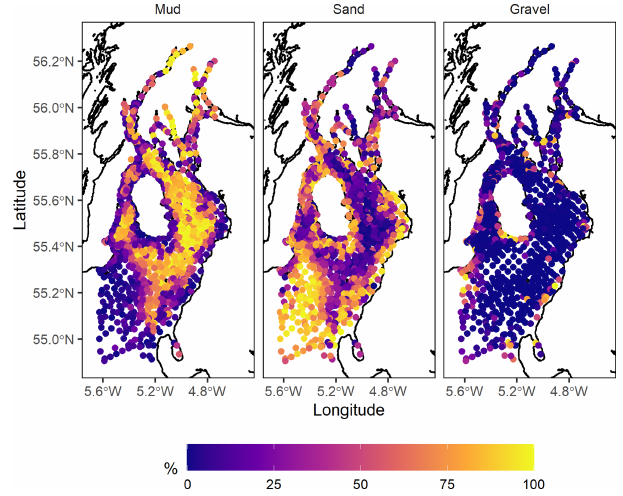
Figure 2. Locations sampled by BGS, MSS, and SEPA for the mea- surement of percentage mud, sand, and gravel in seabed sediments in the Firth of Clyde.